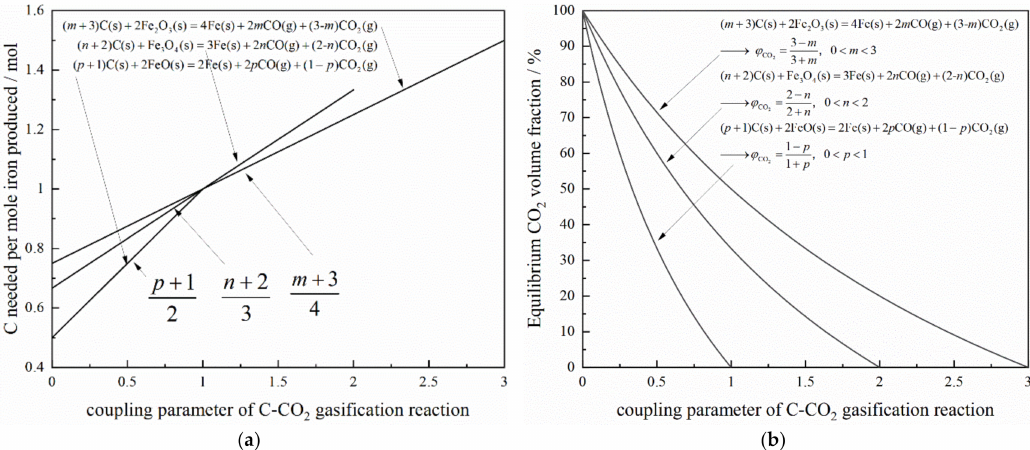
Figure 14. The variables as a function of coupling parameter: ( a ) C needed per mole iron produced; ( b ) equilibrium CO 2 volume fraction.